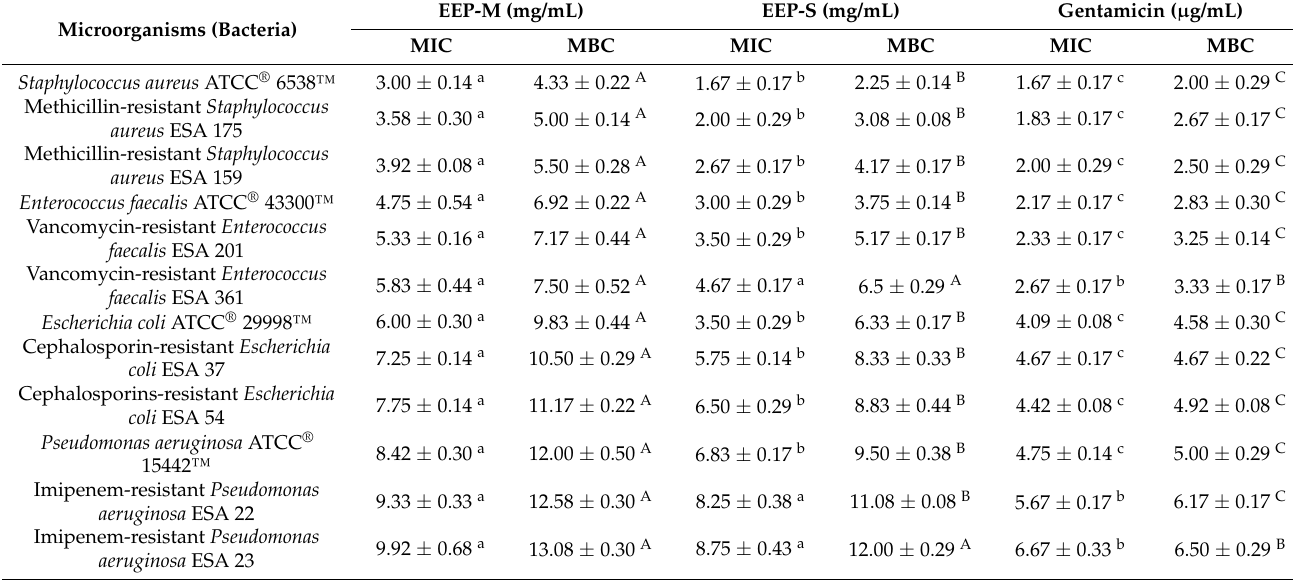
Table 3. Minimum inhibitory concentration (MIC) and minimum bactericidal concentration (MBC) for the studied bacteria, gram-negative and gram-positive.